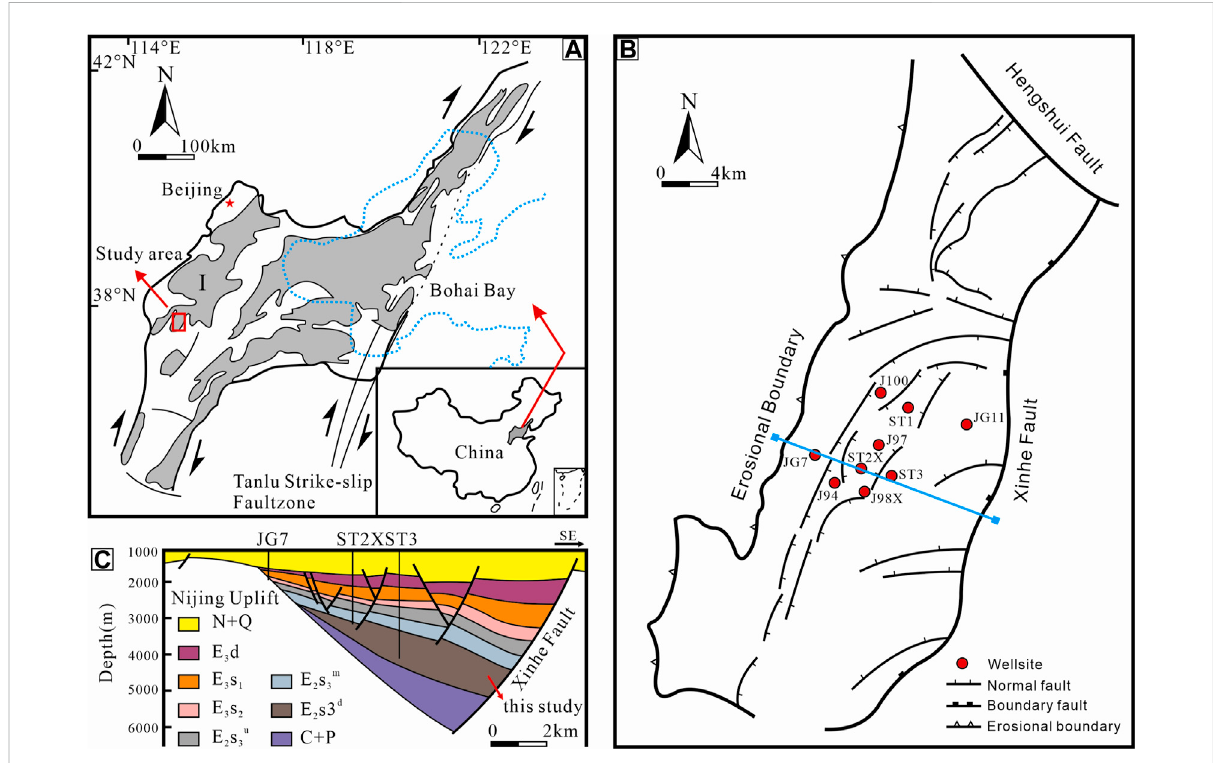
FIGURE 1 Location and structural map of the Shulu Sag: (A) , tectonic setting of the Shulu Sag, located in the southwestern corner of the Jizhong Depression (I); (B) , structural outline map of the Shulu Sag; (C) , transverse section across the middle segment of the Shulu Sag, the position of the section is represented as a blue line in (B)